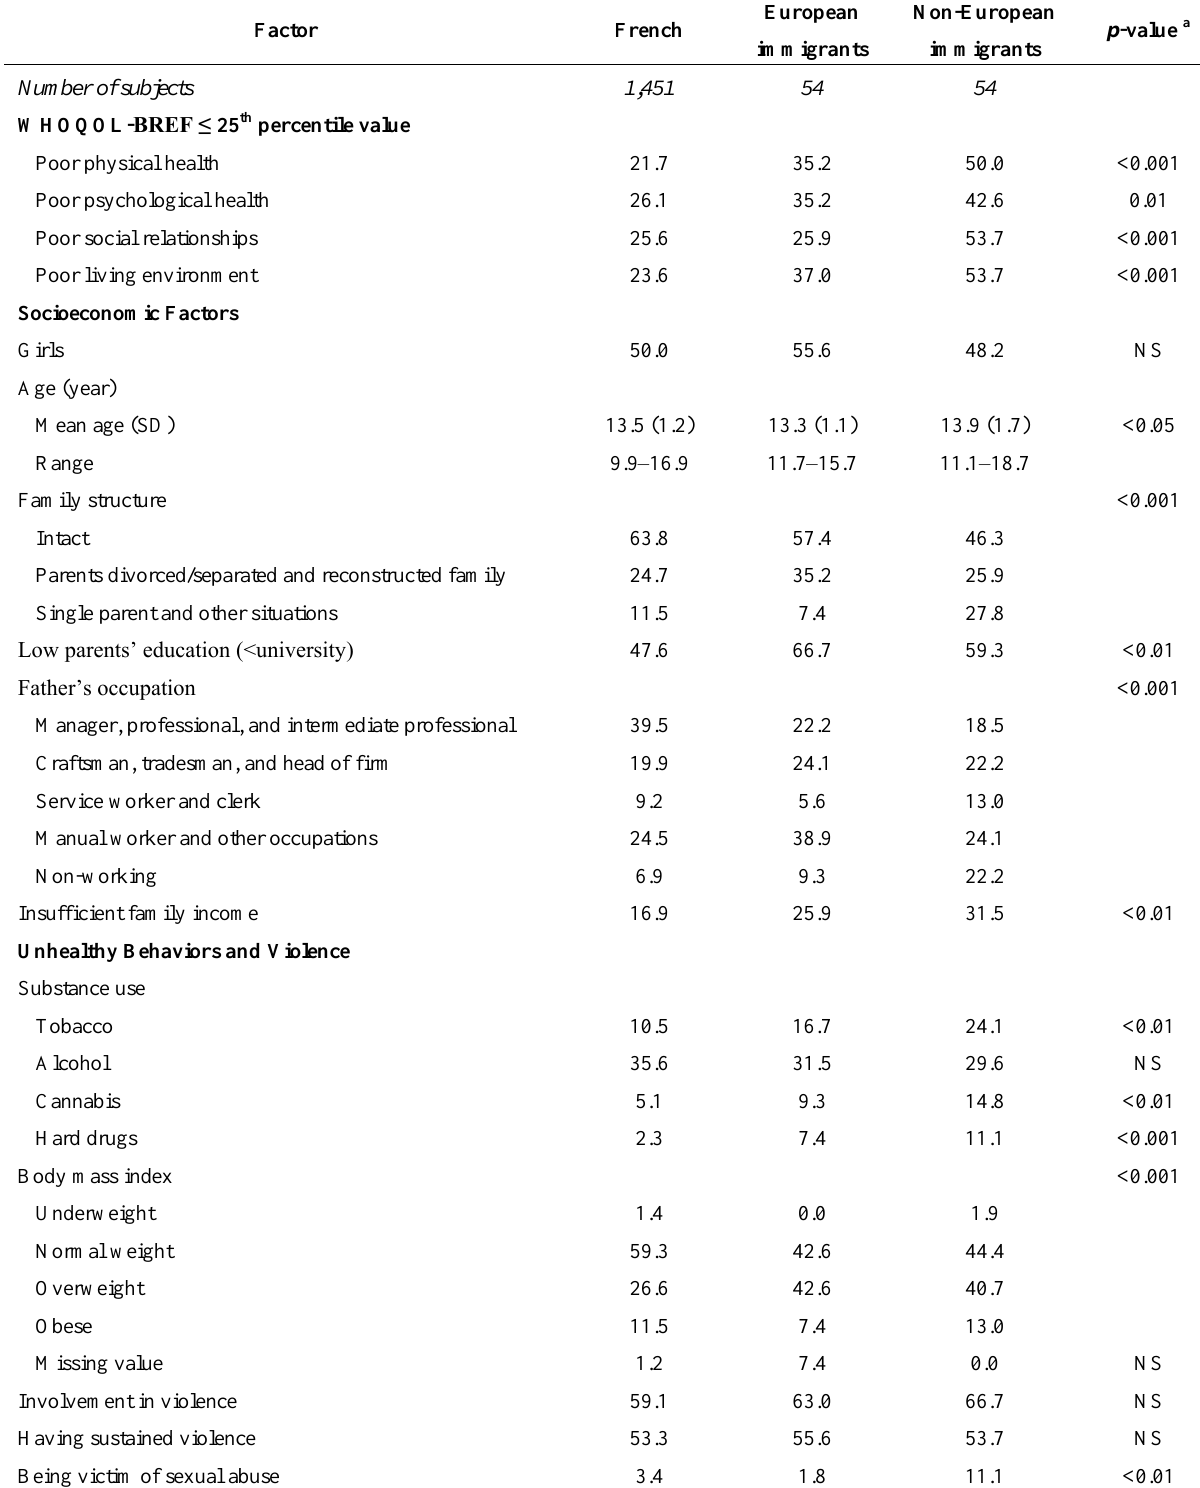
Table 2. Associations between nationality and various factors: % or mean (SD). Factor French